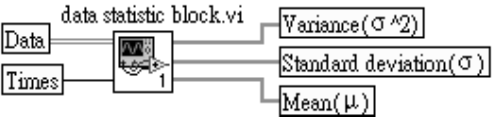
Figure 4. Data statistic block integrated block diagram of Figure 3 with variance, standard deviation and mean.